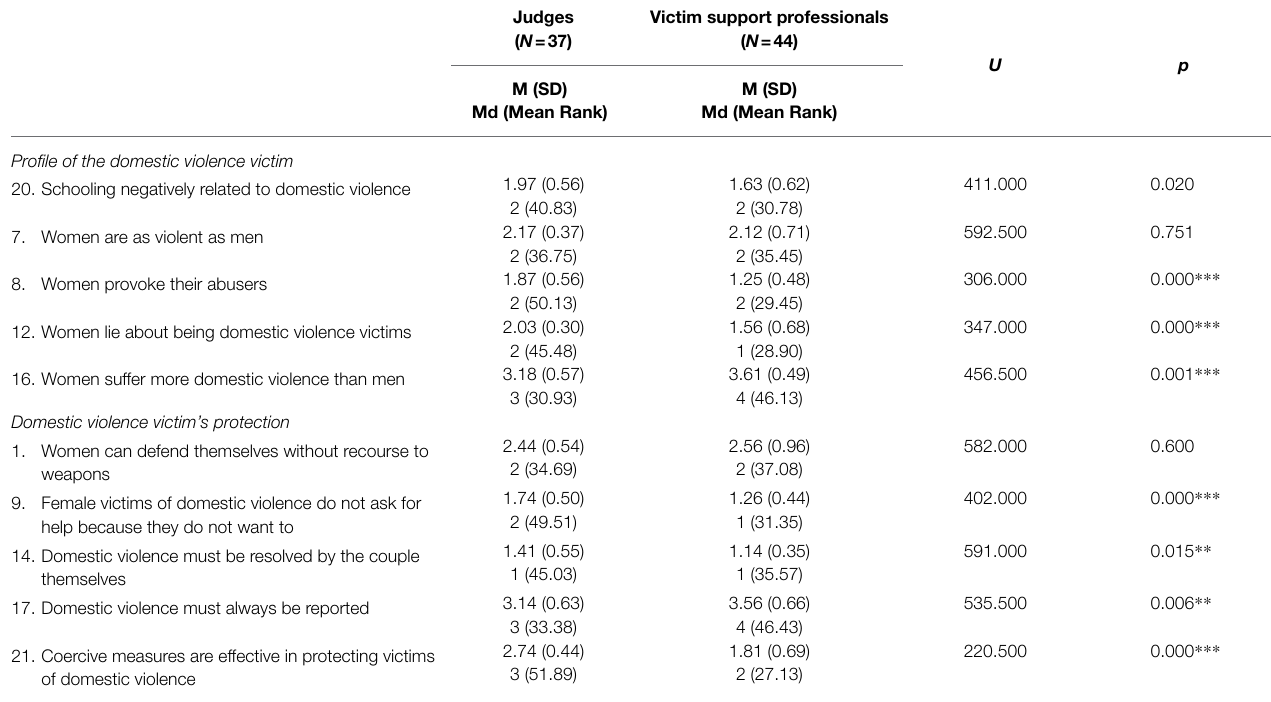
TABLE 1 | Evaluation of attitudes of Portuguese judges and victim support professionals toward domestic violence.